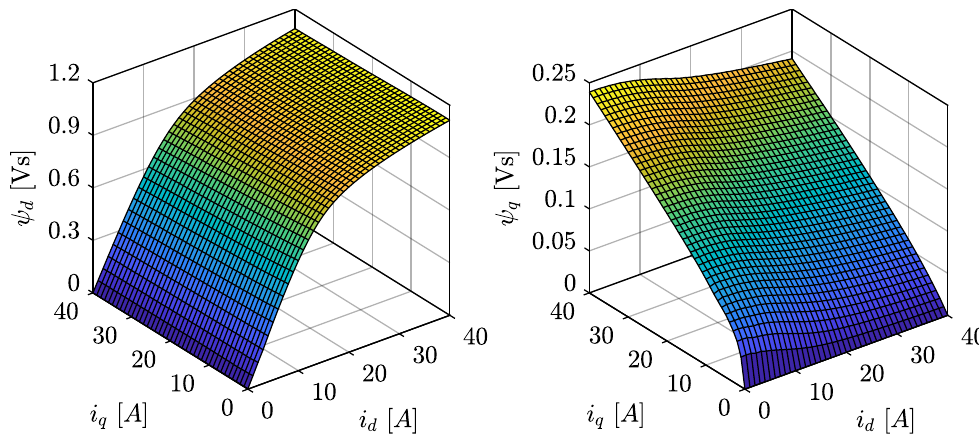
Figure 9. Identified d -axis flux linkage ( left ) and q -axis flux linkage ( right ) maps by